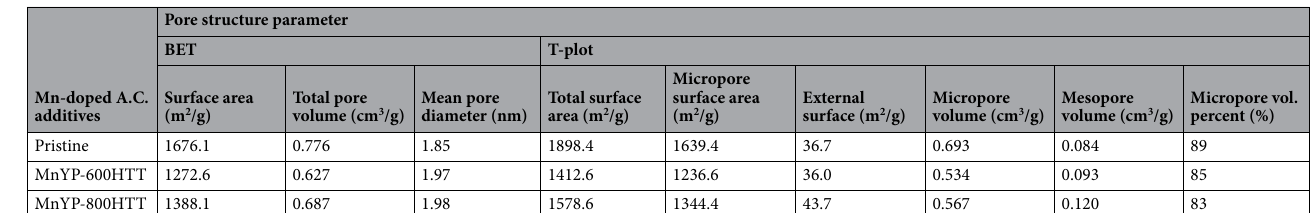
Table 1. Nitrogen adsorption–desorption isotherms of Pristine, Mn-doped MnYP-600HTT and MnYP-